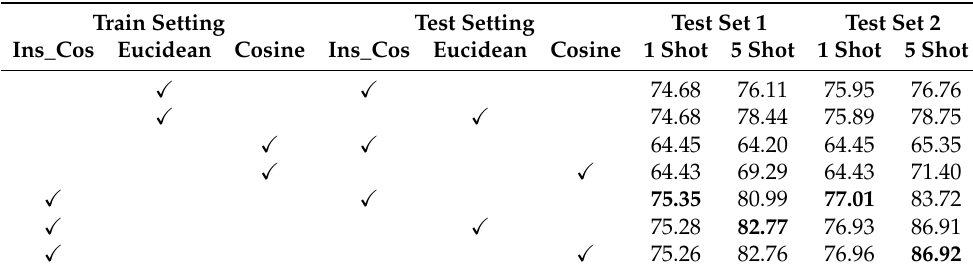
Table 3. Performance results of different train-test distance calculation combinations. Bold type indicates the best performance. Train